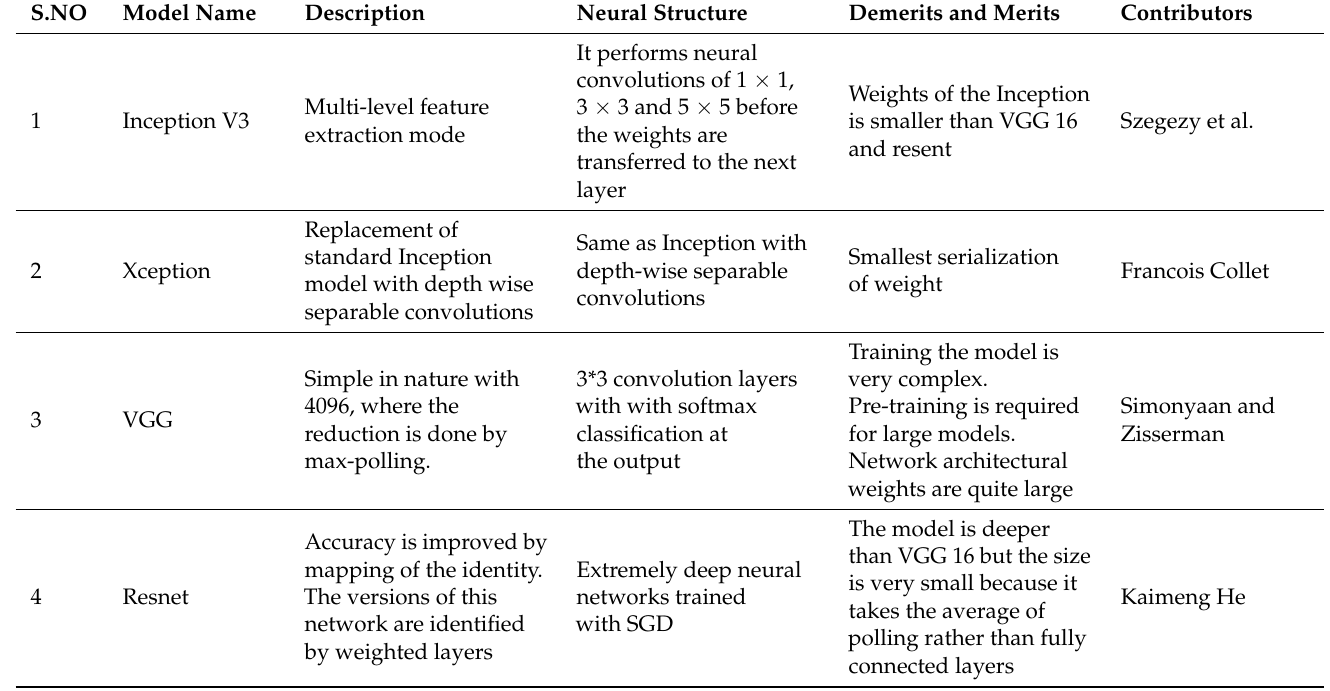
Table 7. Various deep learning models used with required